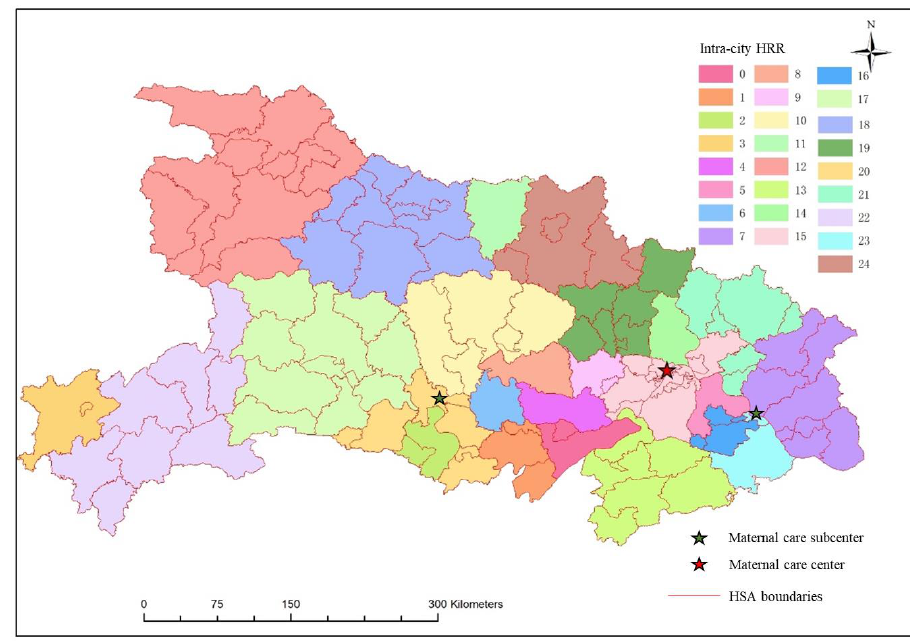
Figure 10. Two-tier system of referral relationship.